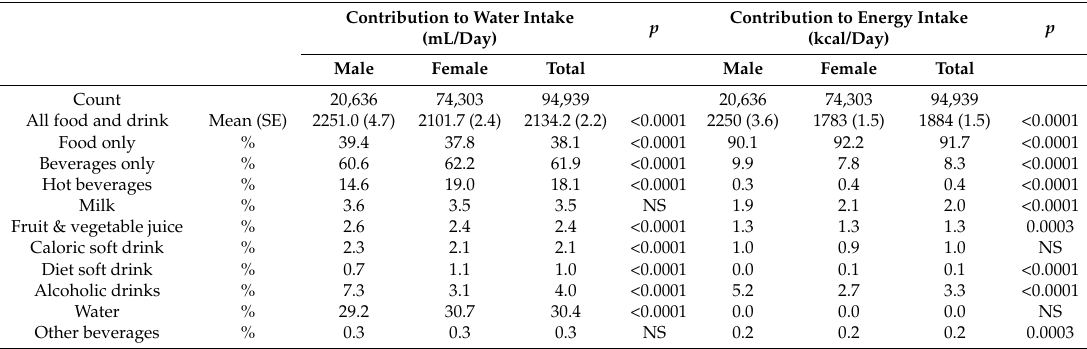
Table 2. Contribution of food and beverages to total water (mL/day) and energy intake (kcal/day) for the whole sample and by gender.